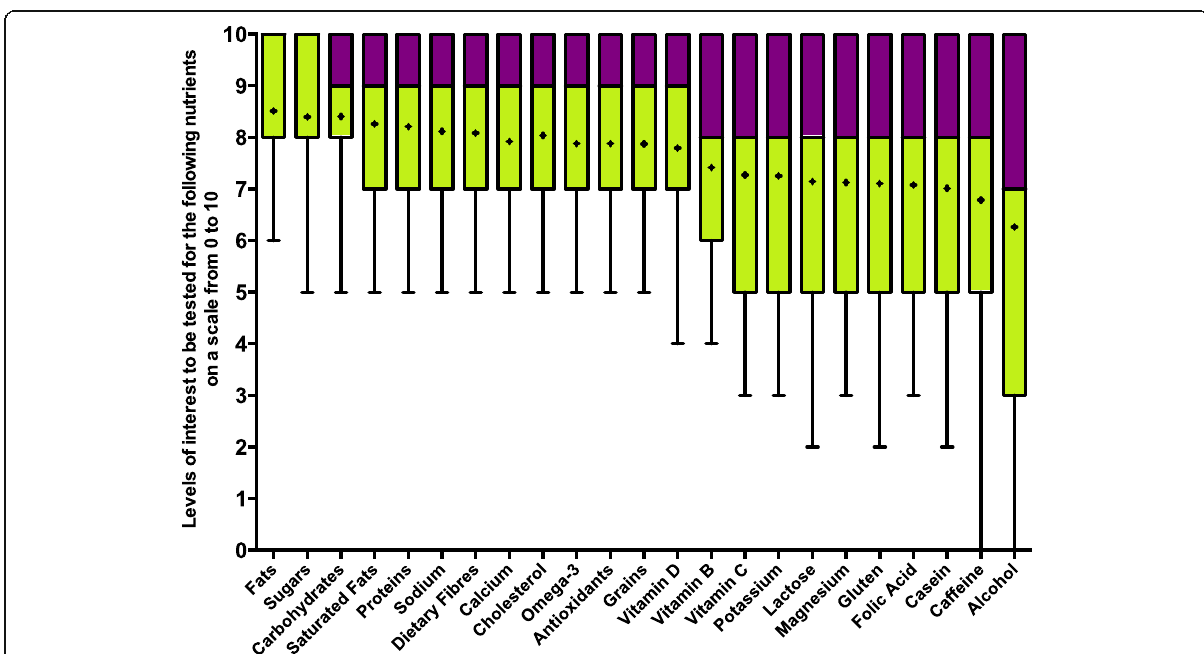
Fig. 2 Box plot showing levels of interest to be tested for nutrients. The dots are the means, the bar separating the colours is the median, the bottom of the box is the 25th percentile and the whiskers are the minimum